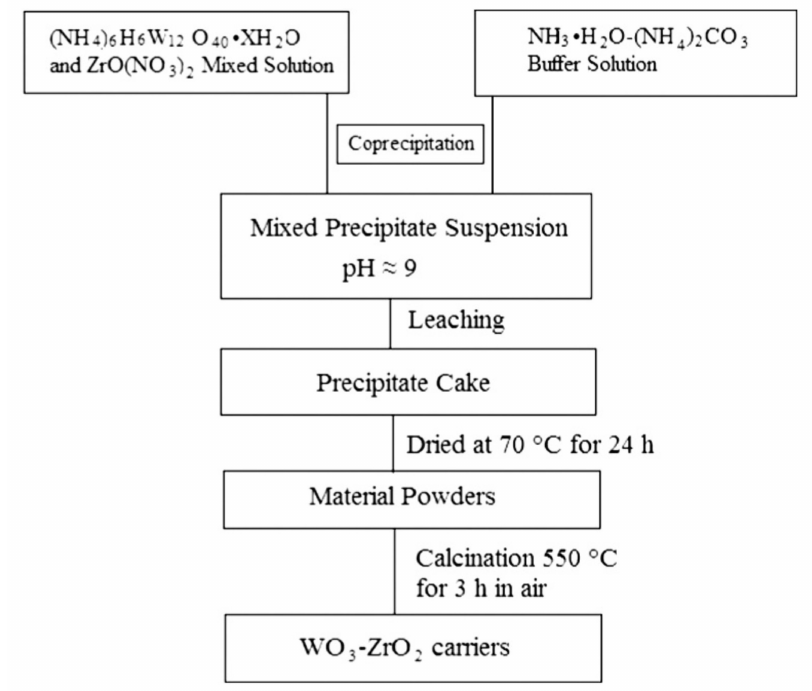
Figure 2. Preparation procedure of the carrier catalysts. Reproduced with permission from Refer- ence [46]; copyright (2012),